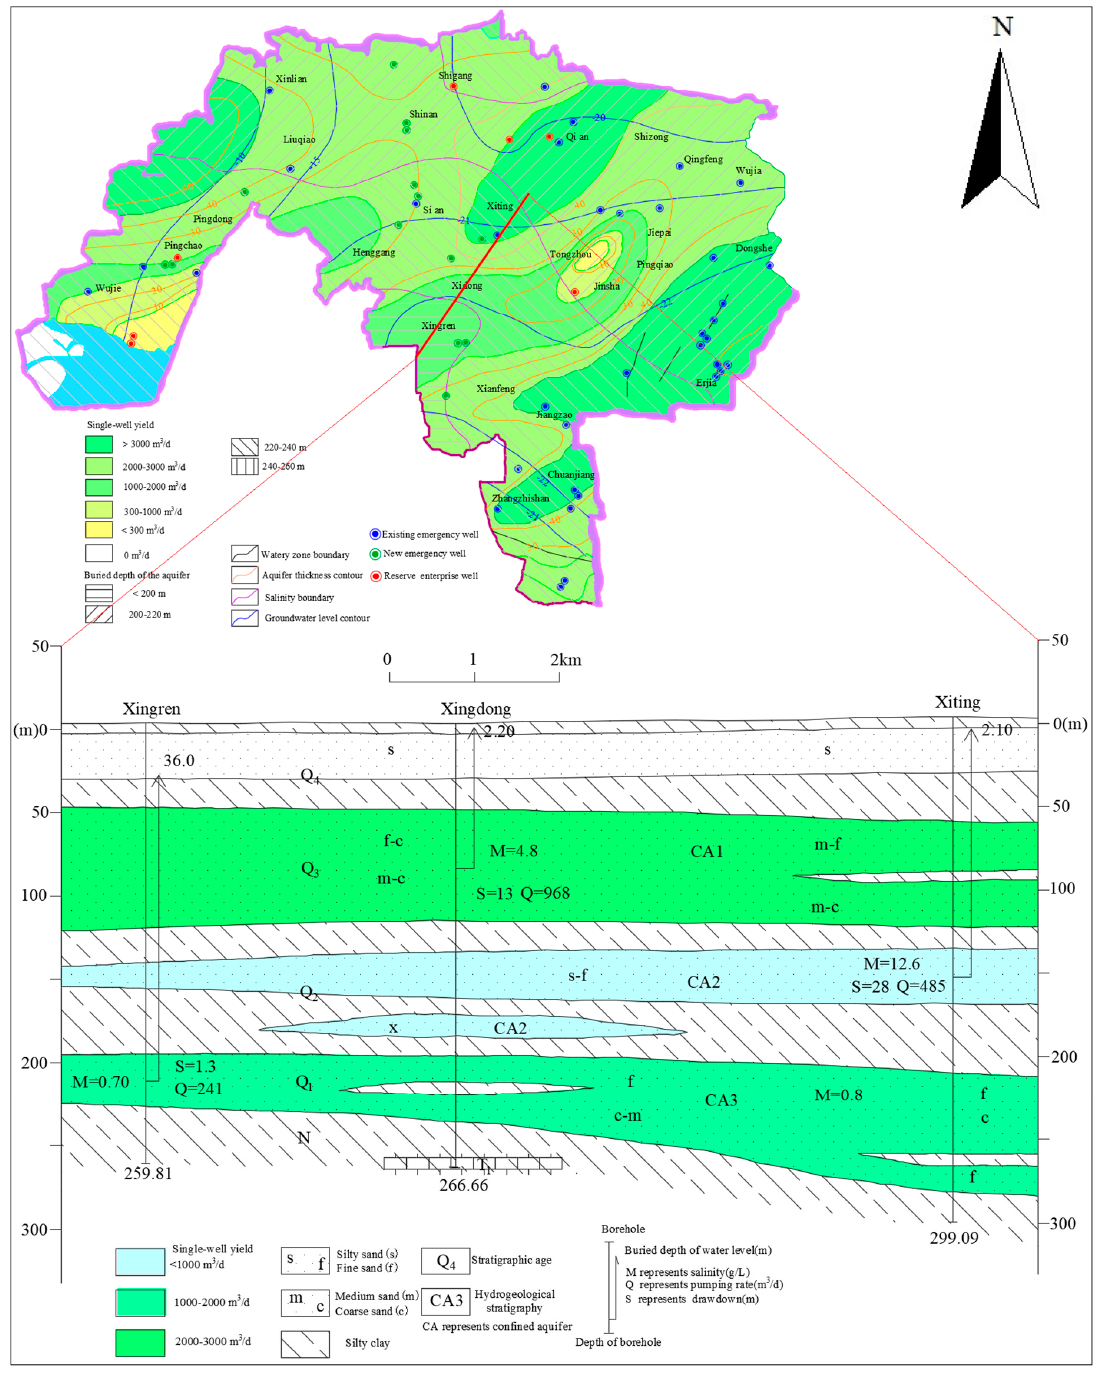
Figure 3. Hydrogeological map of the study area.